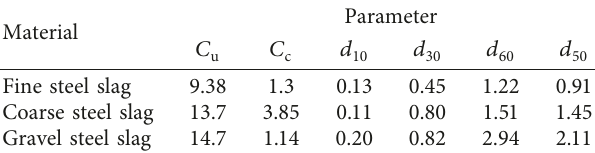
Table 2: Particle size parameters of three kinds of steel slag (mm).